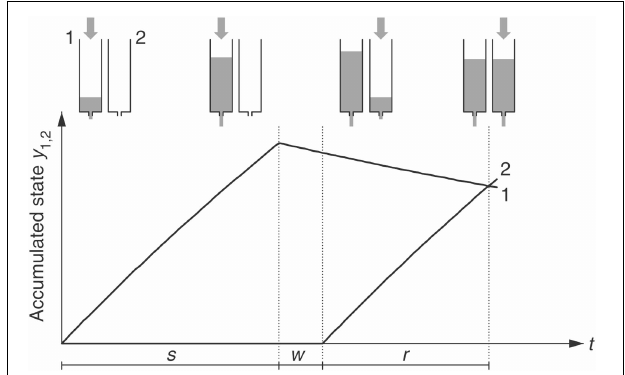
FIGURE 1 | Dual klepsydra model of duration reproduction. s = encoded duration, w = inter-stimulus interval, r = reproduced duration. [From Wackermann and Ehm (2006) with permission from Elsevier